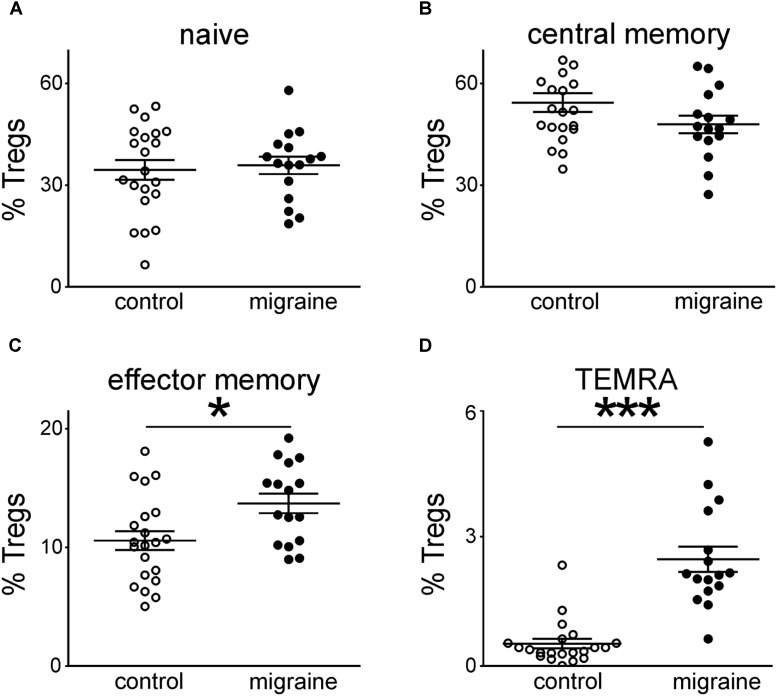
Peripheral blood regulatory T-cells (CD3+CD4+CD25hi) subsets gated on the base of CD45R0 and CD62L expression in healthy controls (white, n = 21) and patients with migraine (black, n = 16). Percentages of “naïve” (CD45R0-CD62L+) (A), central memory (CD45R0+CD62L+) (B), effector memory (CD45R0+CD62L-) (C), and TEMRA (CD45R0-CD62L-) (D) in Tregs cells from peripheral blood. Horizontal lines indicate mean ± SEM. The differences between the groups are shown according to non-parametric Mann-Whitney test (∗p < 0.05, ∗∗∗p < 0.001).